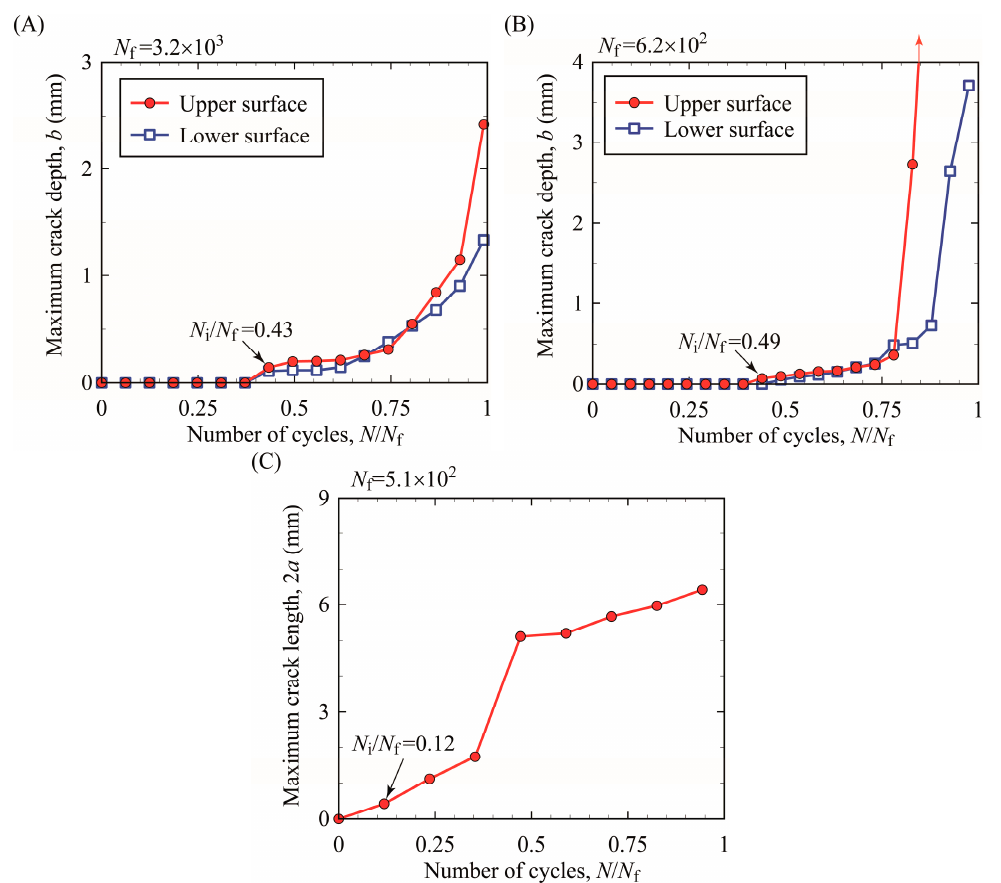
Figure 8. Crack initiation and propagation behavior: ( A ) bending testing ( t = 5 mm) at Δ ε t = 0.02, ( B ) bending testing ( t = 15 mm) at Δ ε t = 0.028, and ( C ) T/C testing at Δ ε t = 0.028.